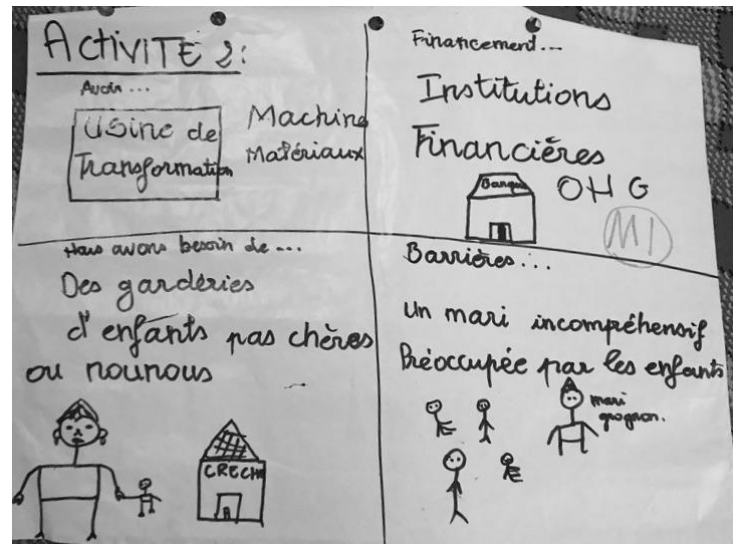
Figure 9. Example from Resource Mapping Activity with Processors.